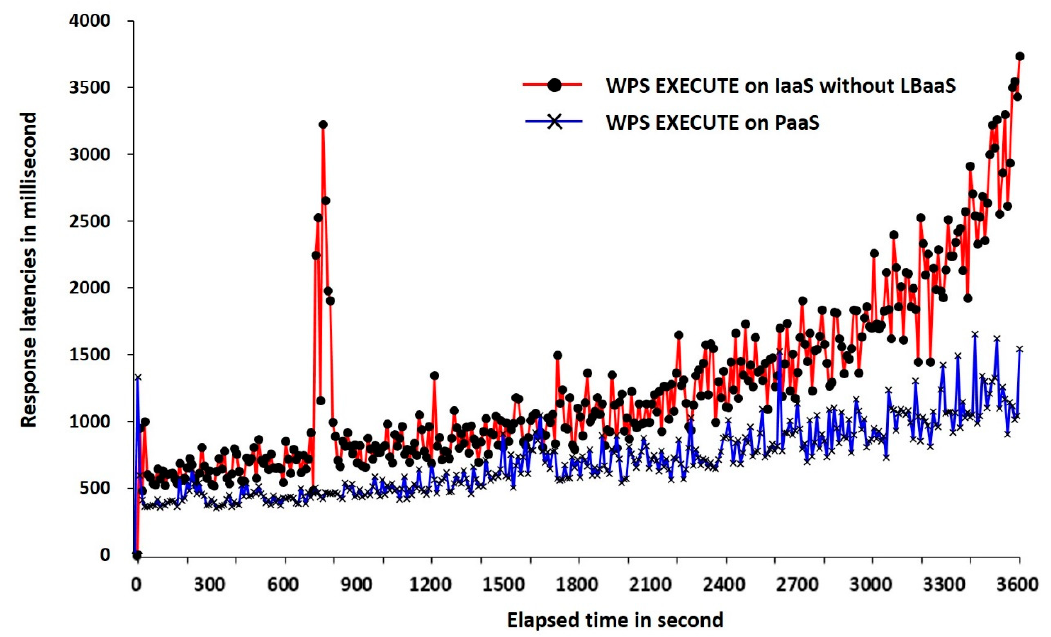
Figure 6. Performance test result for OGC WPS 2.0, executing an operation with an edge detection algorithm, on PaaS and IaaS without LBaaS: a case of 700 threads for 3600 s.